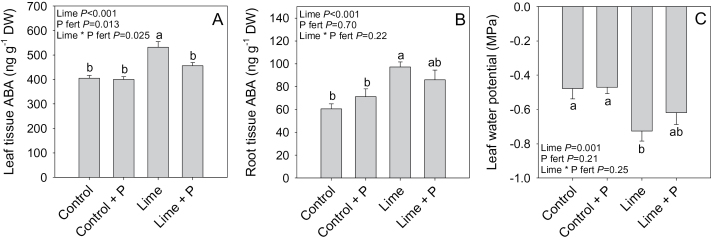
Leaf (A) and root (B) tissue ABA concentrations and leaf water potential (C) of control, control+P fertilizer-, lime-, or lime+P fertilizer-treated Pisum sativum. Data are means ±SE of 8–10 replicates with two-way ANOVA results (P-values reported) shown. Different letters above each bar indicate significant differences (P<0.05) as determined by Tukey pair-wise analysis.